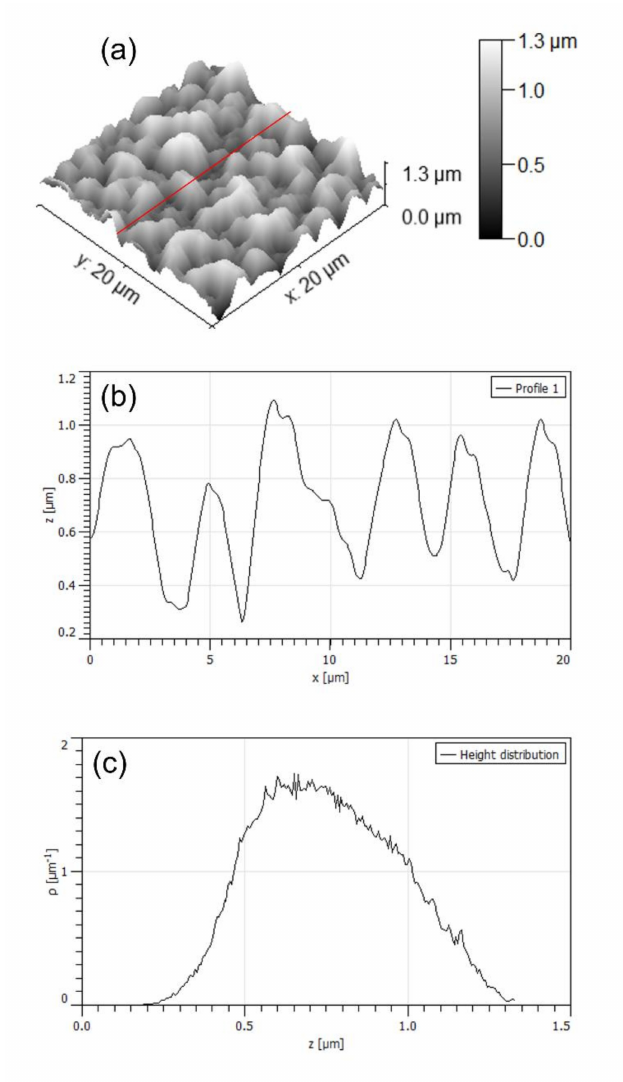
Figure 9. ( a ) Three-dimensional AFM image, ( b ) profile and ( c ) height distribution of the thiol-ene surface hot embossed at 100 ◦ C under 30 MPa and aged for two months in air at standard room conditions. The red line indicates the location where the AFM profile was